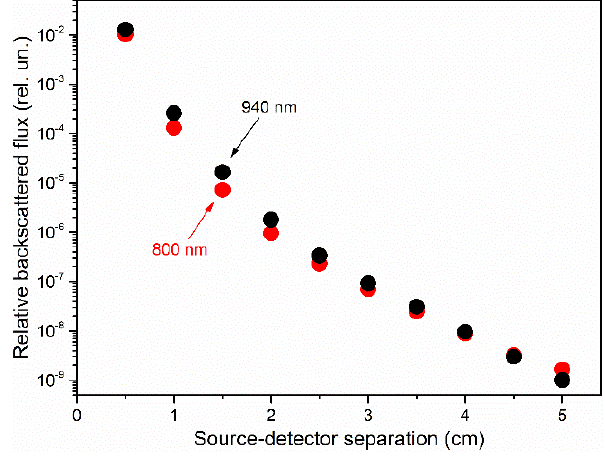
Figure 6. Relative backscattered flux vs. SDD calculated by MC simulation in the planar layer model for the wavelengths of 800 nm (red) and 940 nm (black).